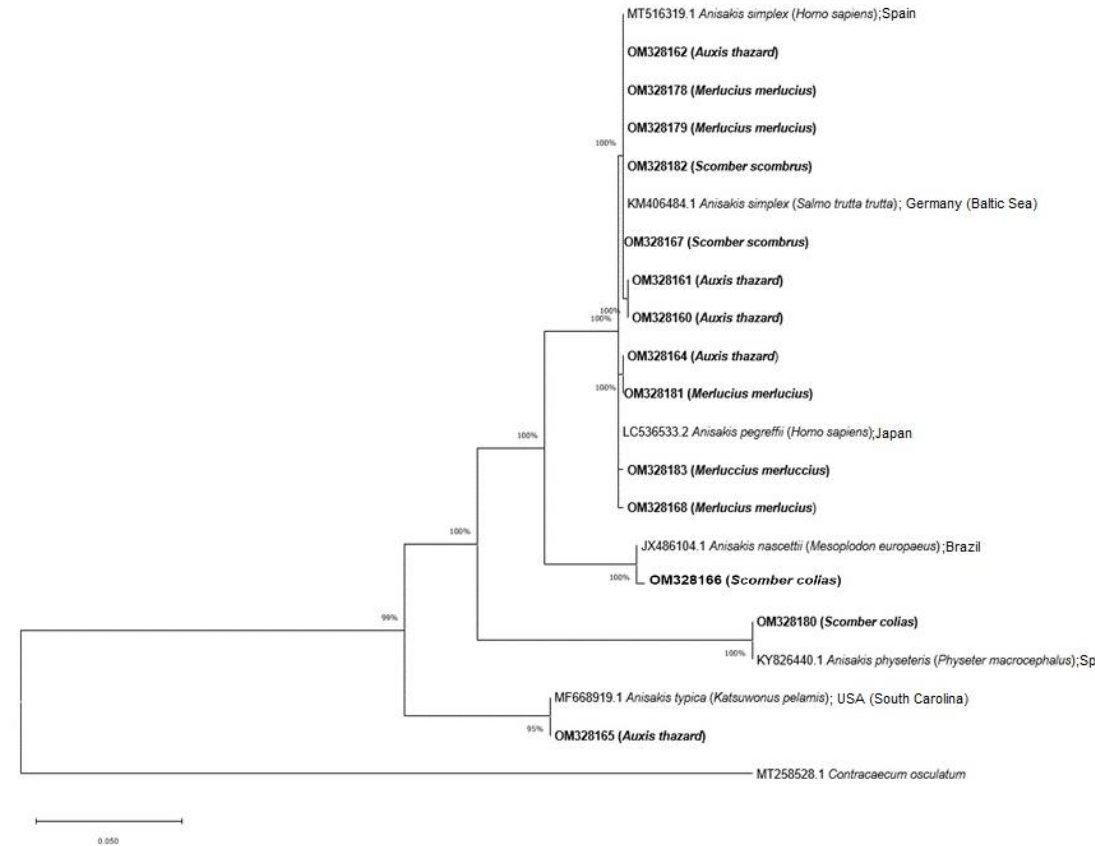
Figure 2. Phylogenetic analysis using the neighbor-joining method with p-distance and 1000 bootstrap replications based on the entire ITS rDNA region. Sequences exploring the relationships among Anisakis spp., including the nucleotide sequences obtained in this study (shown in bold). Contracaecum osculatum was used as an outgroup.